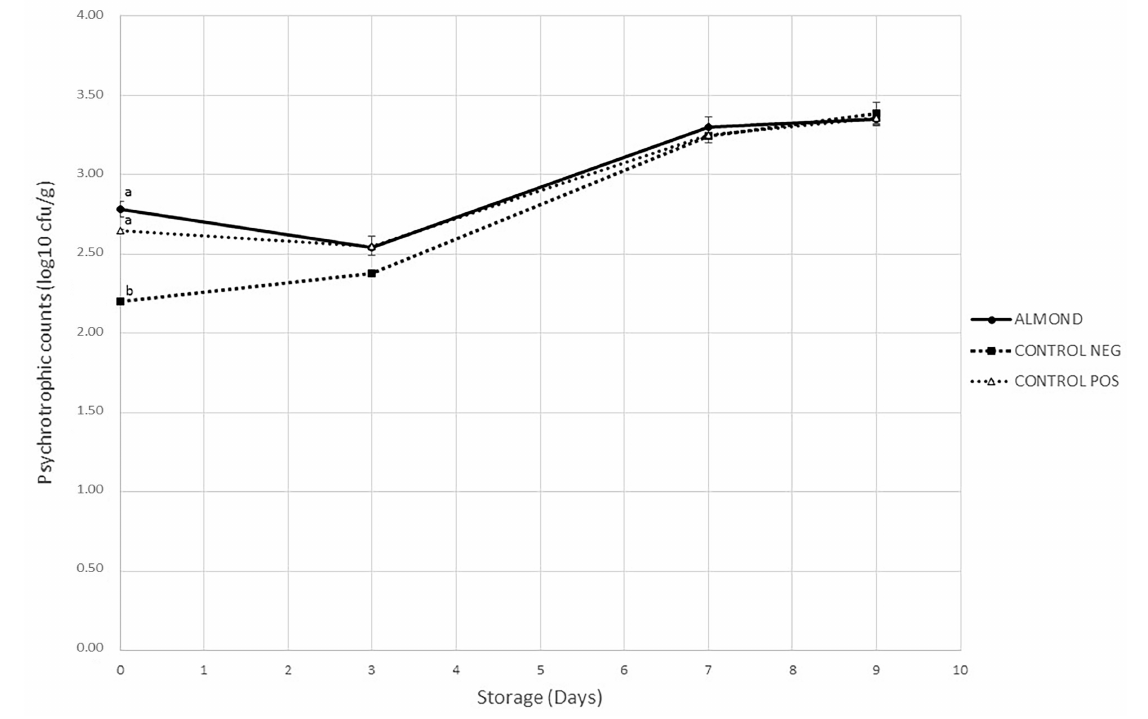
Figure 1. Evolution of psychrotrophic aerobic bacteria counts (log 10 cfu/g sample) in pork patties with different treatments stored in MAP for 9 days. Values are reported as mean ± SD (n = 5). a, b values with different letters on the same day of storage are significantly different ( p < 0.05), Tukey